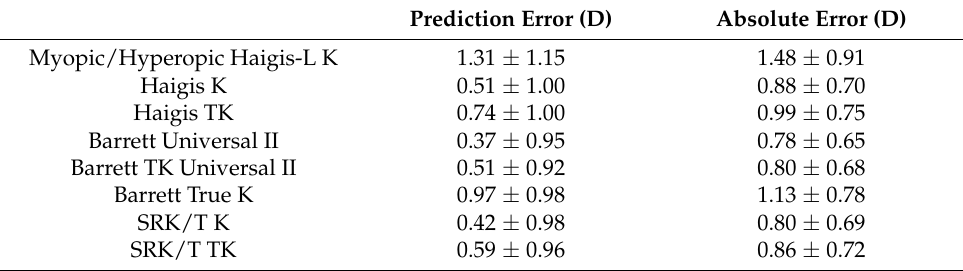
Table 2. The mean prediction and absolute errors and proportions of eyes within ± 0.25 D, ± 0.50 D, and ± 1.00 D of the predicted postoperative spherical equivalent refraction at 2 months after surgery.